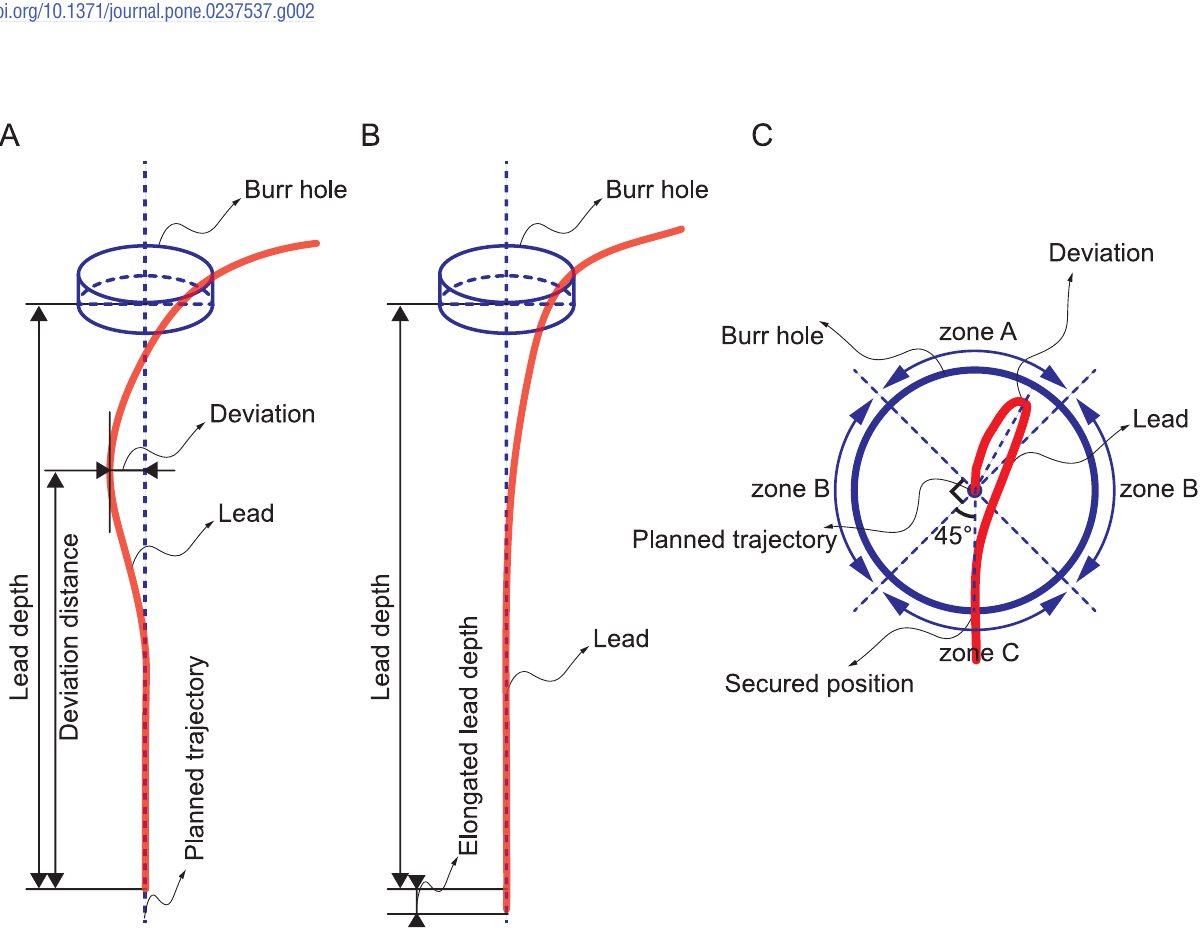
Fig 3. Definition and description of the variables. A. Concept of lead bending immediately after surgery. B. The bent lead was gradually straightened, and the lead depth increased as the lead was locked at the burr hole. C. Drawing of the direction of bending perpendicular to the planned trajectory (center of the circle). The deviated area (zones A, B, and C) were determined when the lead locking position was regarded as 0˚.